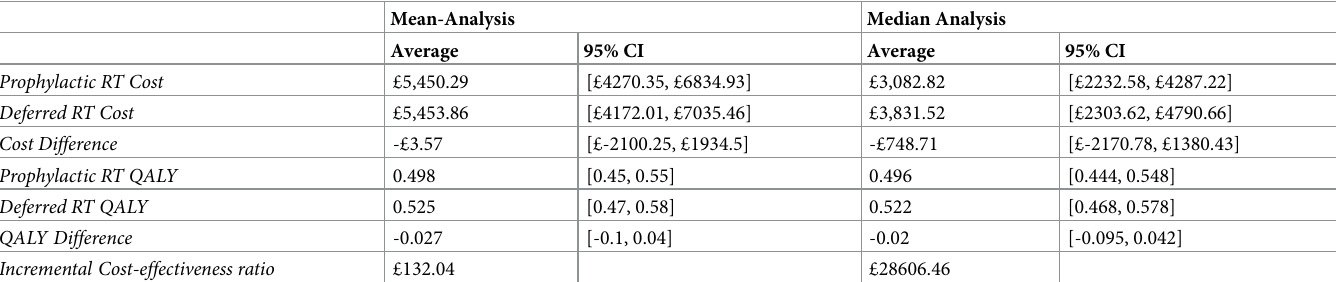
Table 4. Summary of the cost-effectiveness analysis, with incremental costs and QALYs, and the resultant